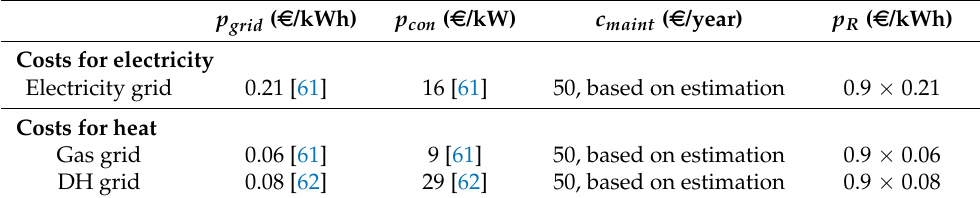
Table 5. Costs for energy